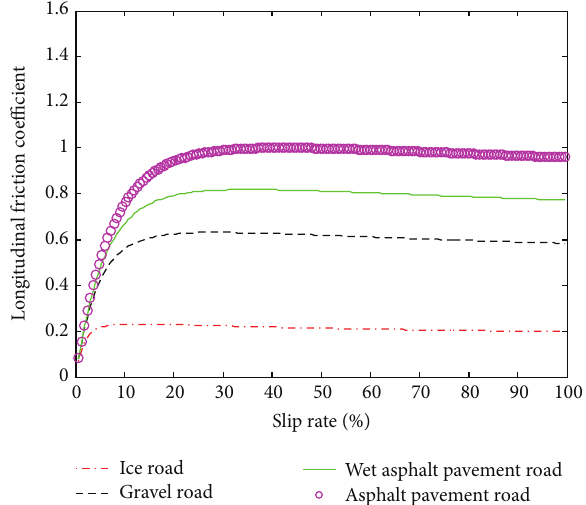
Figure 11: The LuGre tire model.